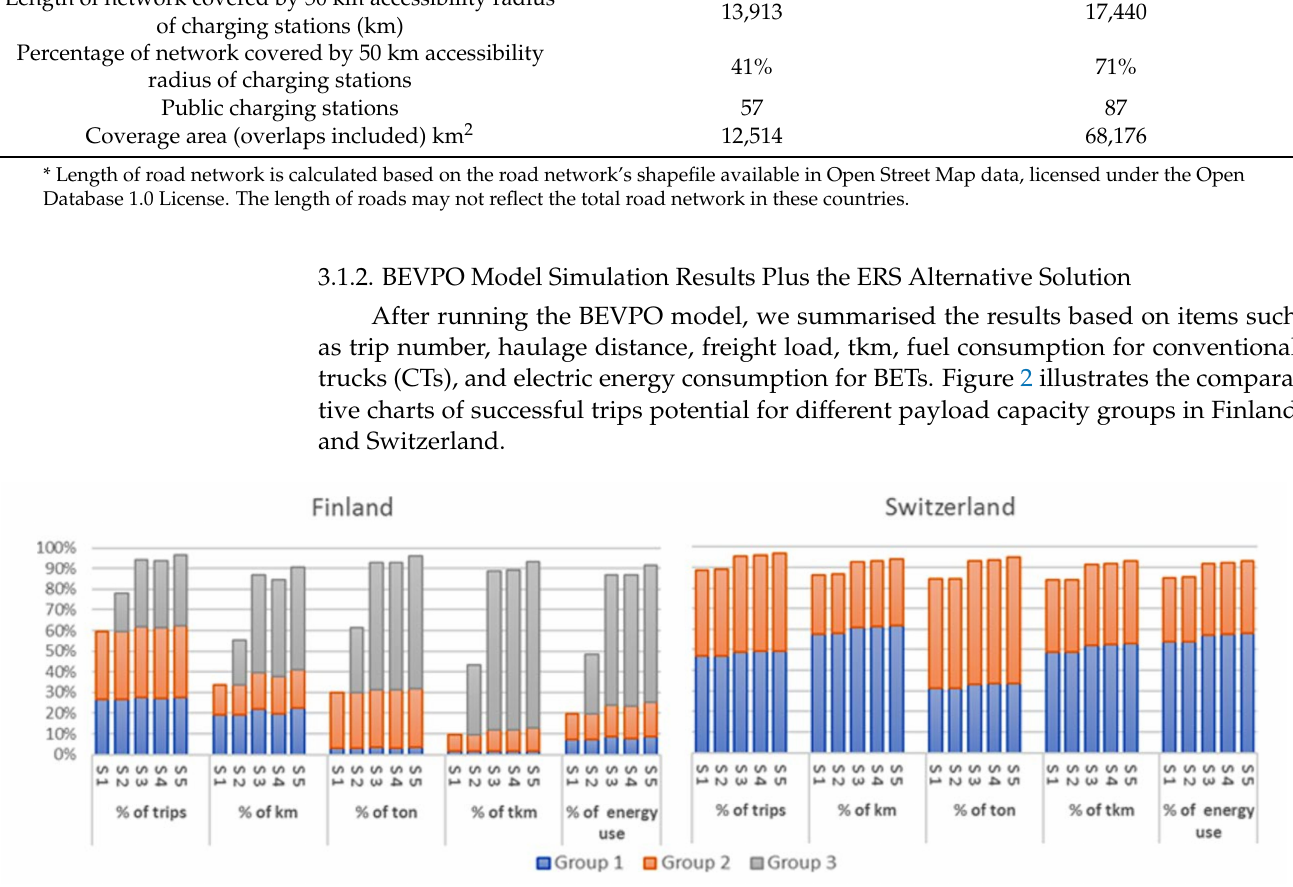
Figure 2. Comparative analysis of successful trips in Finland and Switzerland in each scenario for various payload capacity